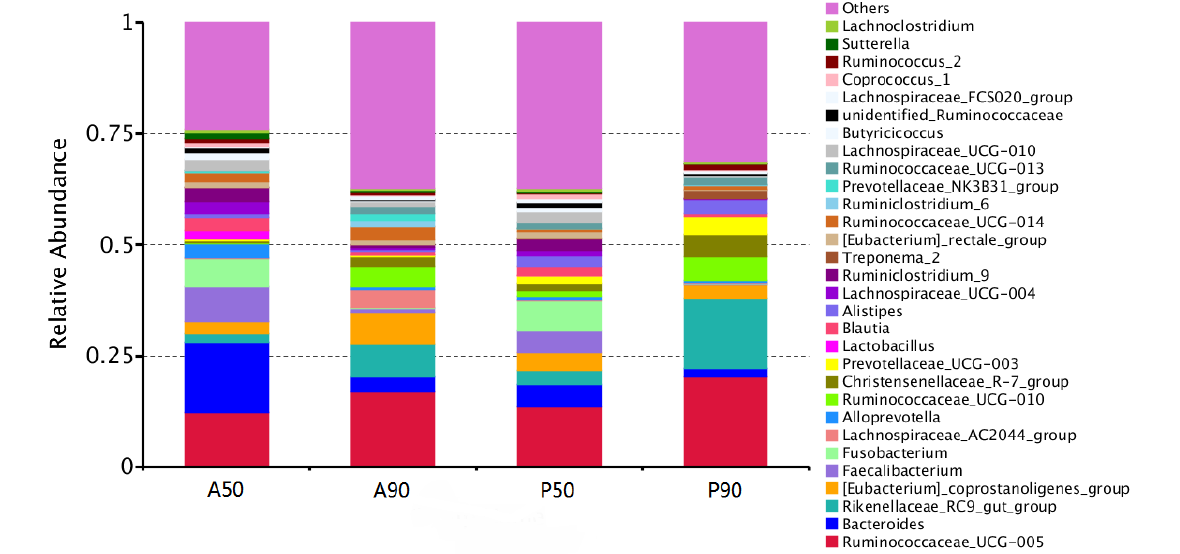
Figure 2. Average relative abundance of microorganisms at the genus level in the feces of calves fed pasteurized milk (PM) and acidified milk (AM) ad libitum. A50, feces samples of calves fed AM on day 50; A90, feces samples of calves fed AM on day 90; P50, feces samples of calves fed PM on day 50; P90, feces samples of calves fed PM on day 90.